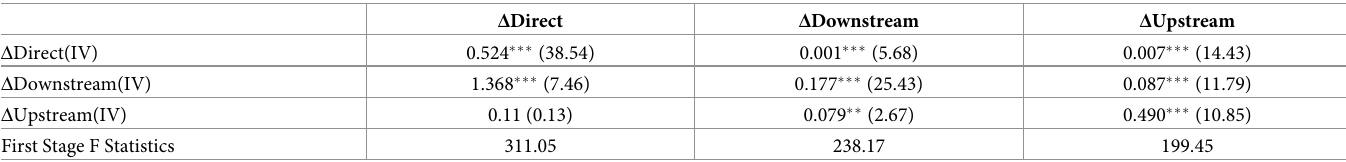
Table 7. First stage results of instrumental variable method.